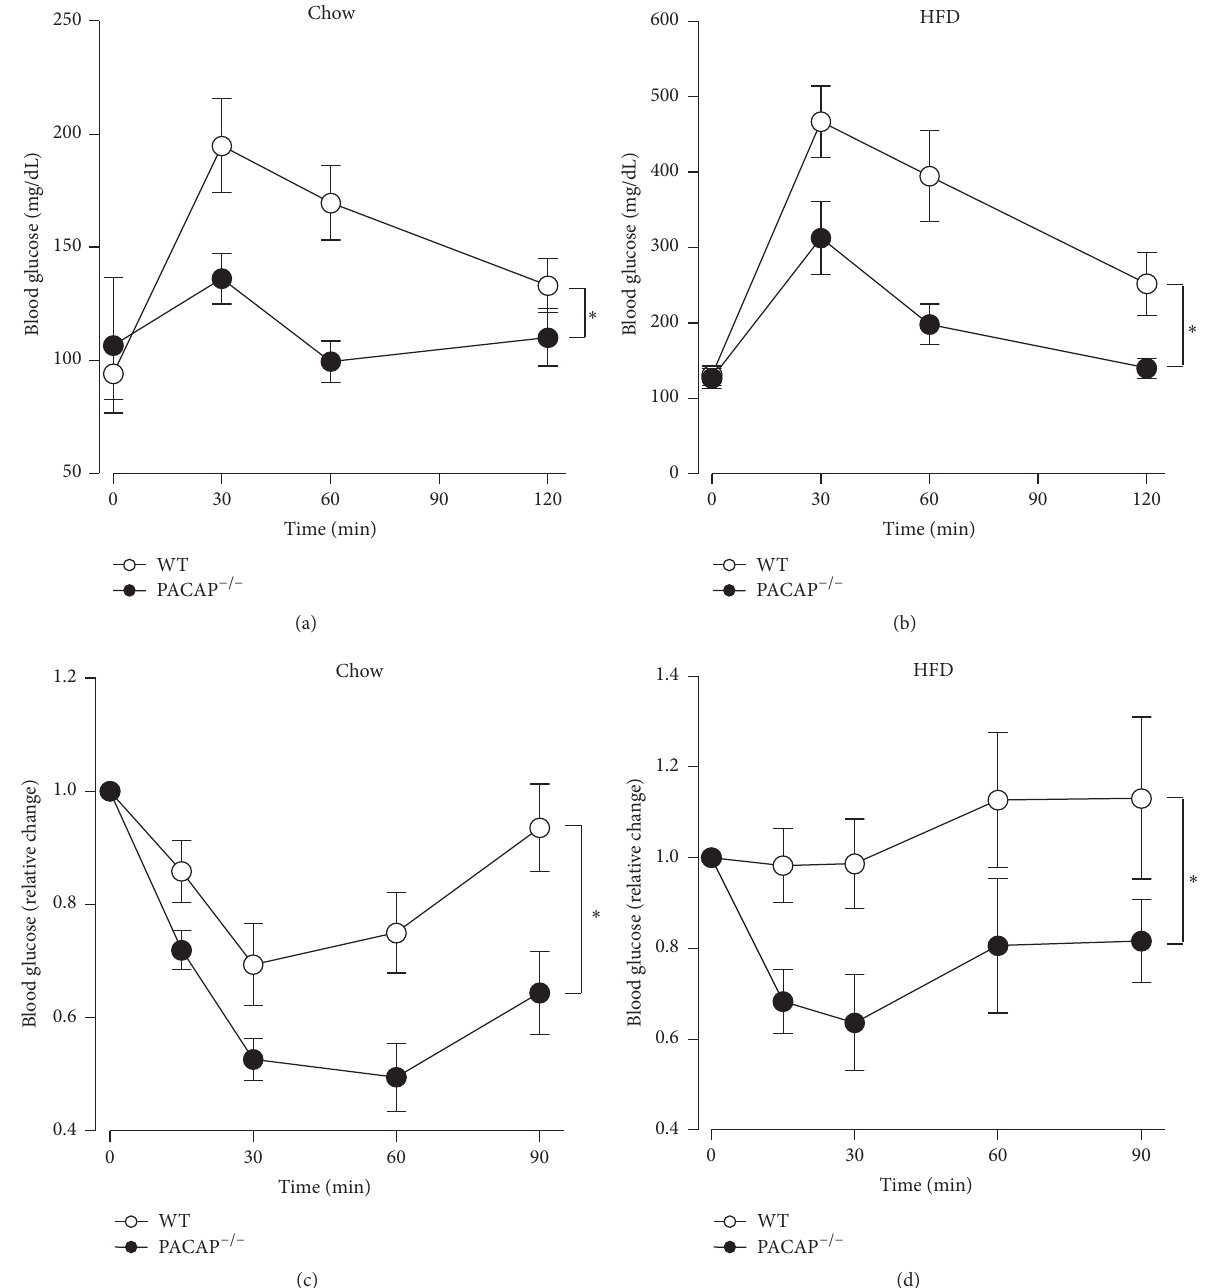
Figure 1: Effects of HFD on glucose tolerance and insulin tolerance in wildtype and PACAP null mice. (a) and (b) Blood glucose levels in GTT in wild type (WT) (open symbols) and PACAP null mice (filled symbols) fed regular chow (a) and HFD (b) for 6 weeks. Glucose at 2 g/kg body weight was injected to mice fasted 6h. (c) and (d) Blood glucose levels in ITT in WT and PACAP null mice fed regular chow (c) and HFD (d) for 6 weeks. Insulin at 0.5 IU/kg body weight was injected to mice fasted for 6h. All data are presented as means ± s.e.m. ∗ 𝑝 < 0.05